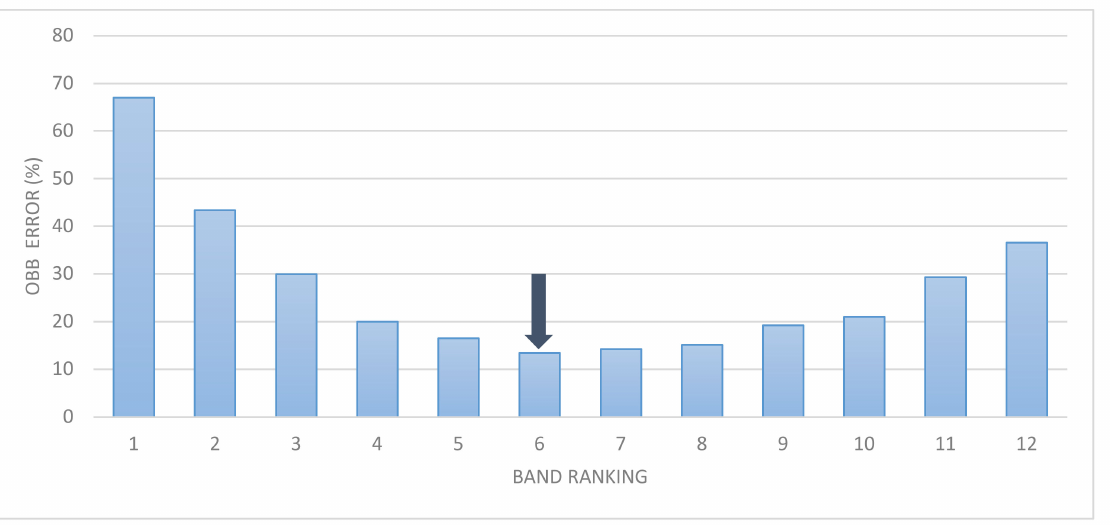
Figure 5. Identification of the optimal variables based on RF MDA rankings produced using the forward variable selection (FVS). The arrow indicates the set of variables that have the lowest error